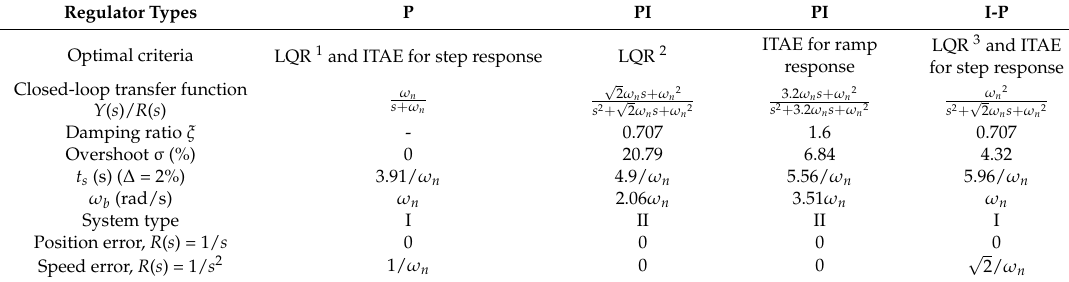
Figure 5. Structural diagrams of optimal control system: ( a ) P regulator; ( b ) PI regulator; ( c ) I-P regulator. Table 2. Performance of closed-loop responses.